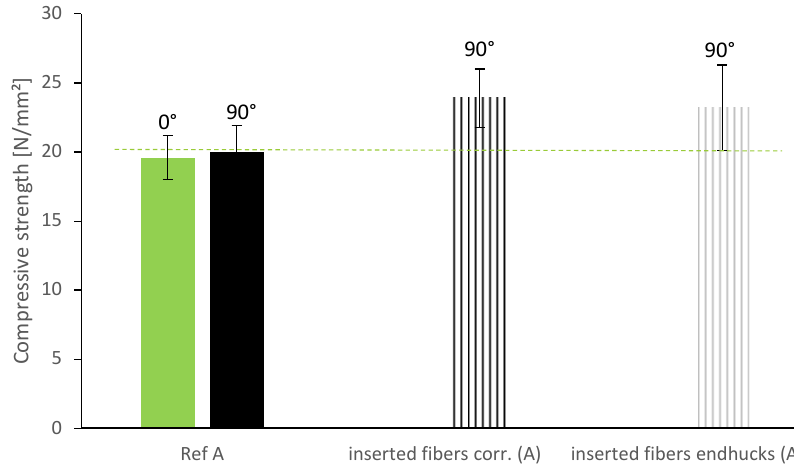
Figure 11. Compressive strength of specimen with vertically inserted fiber reinforcement.